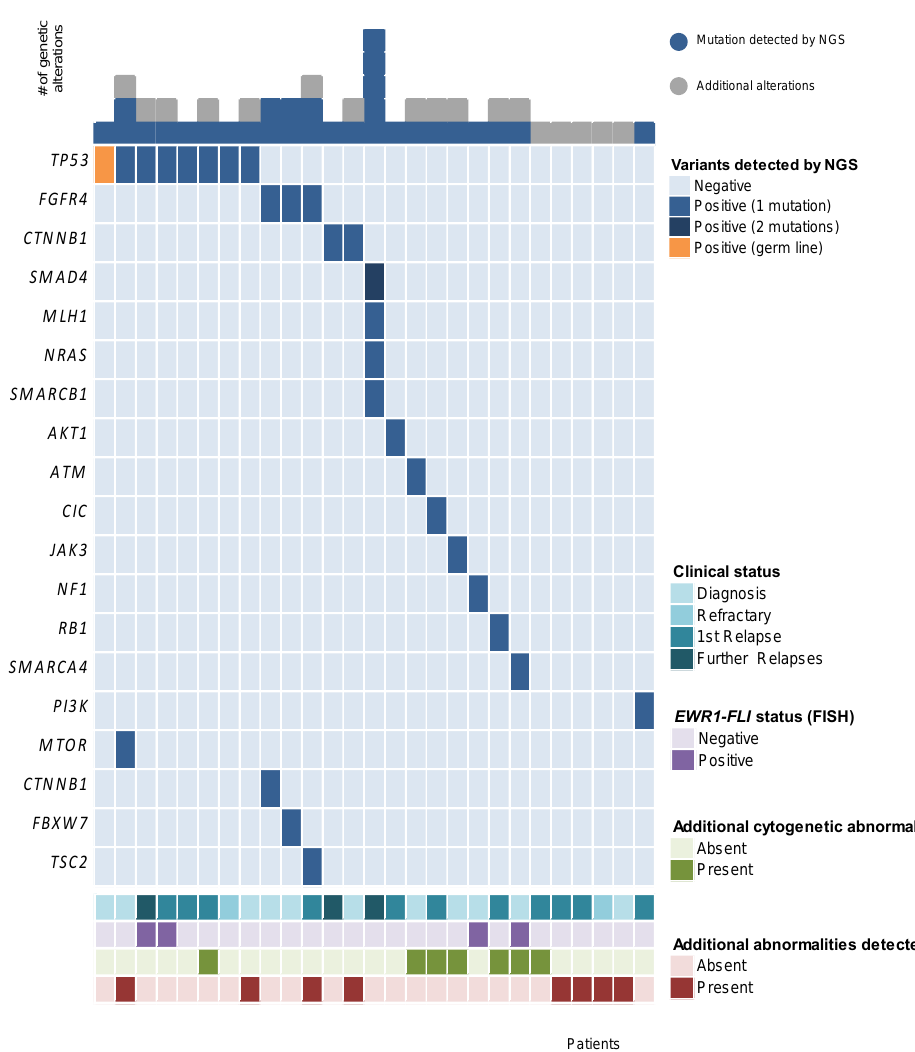
Figure 2. Molecular alterations observed in the 27 patients (each column represents one patient). IHC: immunochemistry.